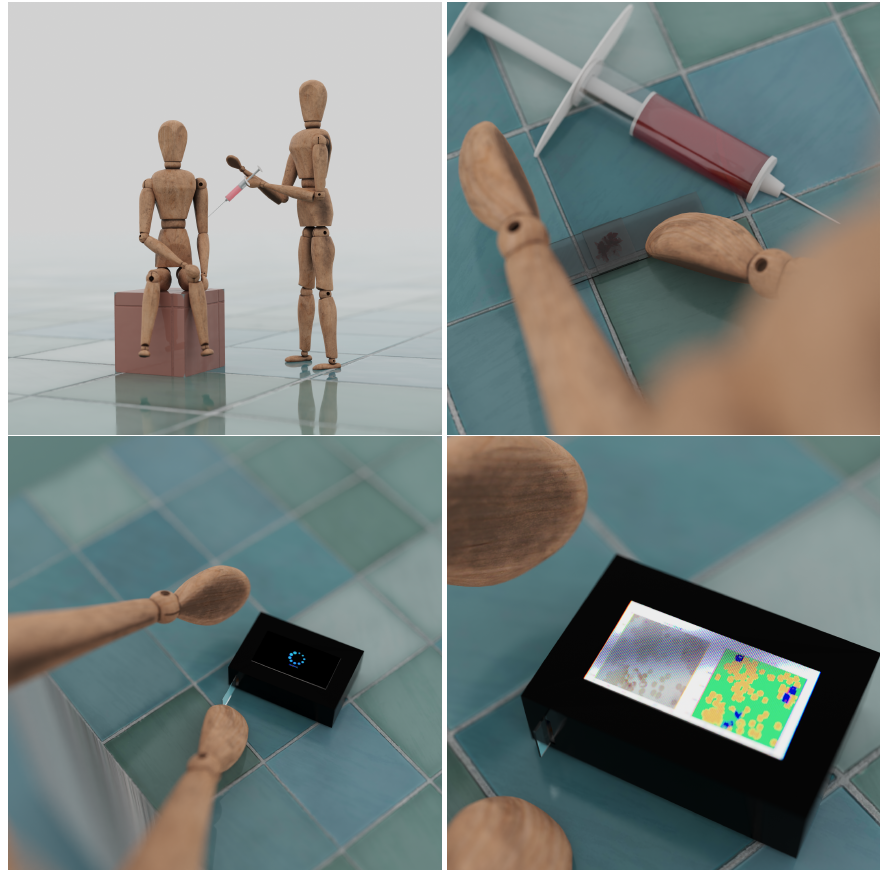
Figure 7. The pictures above are a graphical representations of a user use of our system. It is enough for the appropriate person to take a sample from the patient and place it on laboratory glassware, and the device will easily detect indications of malaria infection by using proposed deep learning